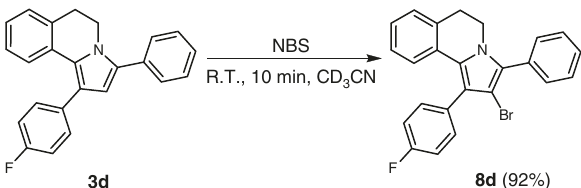
Fig. 5 Derivatization of DHPIQs by electrophilic bromination with